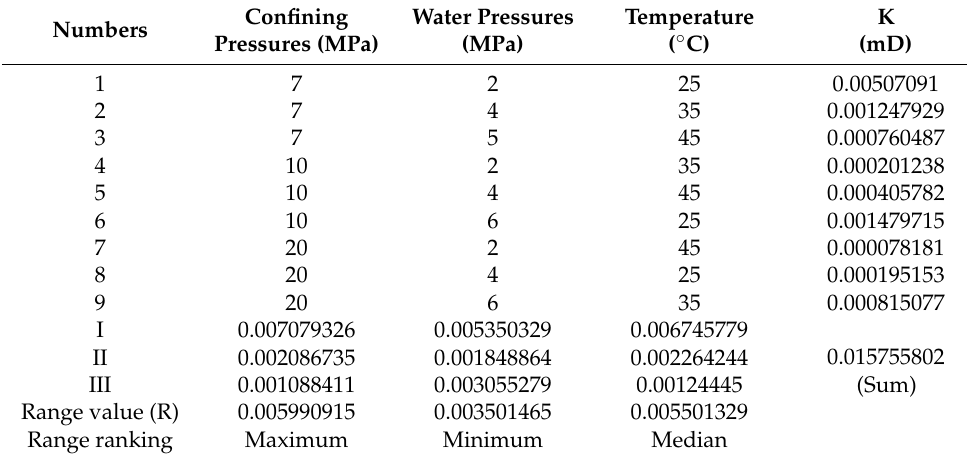
Table 7. Analysis of orthogonal test results for subcategory II 2 sandstone.